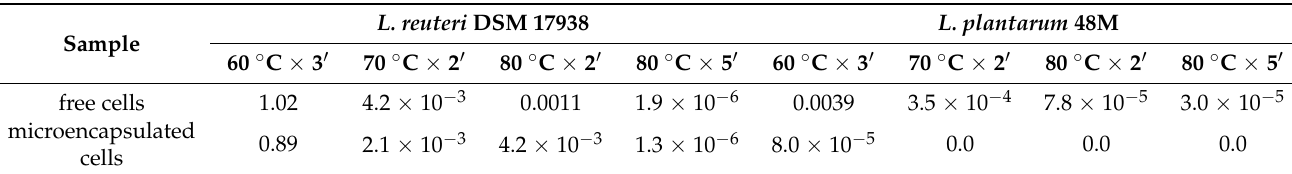
Figure 4. Viable staining of microencapsulated cells of L. reuteri DSM 17938 (panels a , c , e , g ) and L. plantarum 48M ( b , d , f , h ) after different heat treatments as indicated on the right sides of panels. Table 2. Survival rate (%) of free and microencapsulated cells of L. reuteri DSM17938 and L. plantarum 48M after different heat treatments.